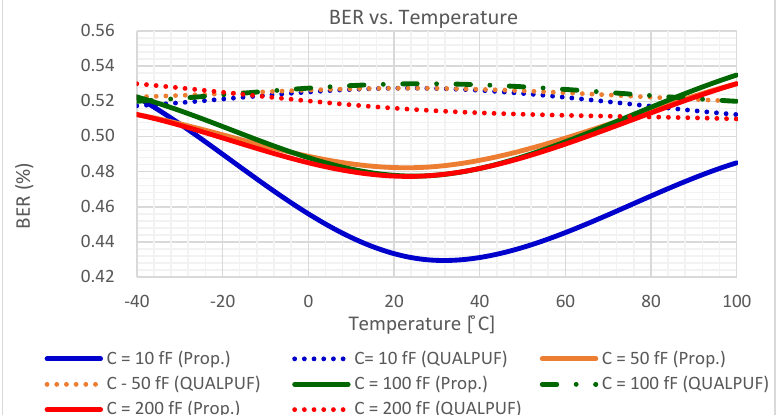
Figure 10. The BER of the proposed FinFET-based TPCA-PUF (labeled as Prop.) versus QUALPUF under the V TH variation (4-bit PUF).